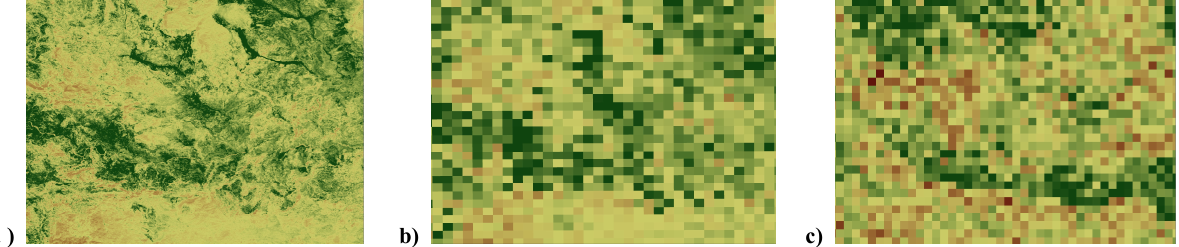
Figure 7. The plots of different model outputs; CASA-30m (a), CASA-1km (b), LPJ-GUESS-1km, (c).